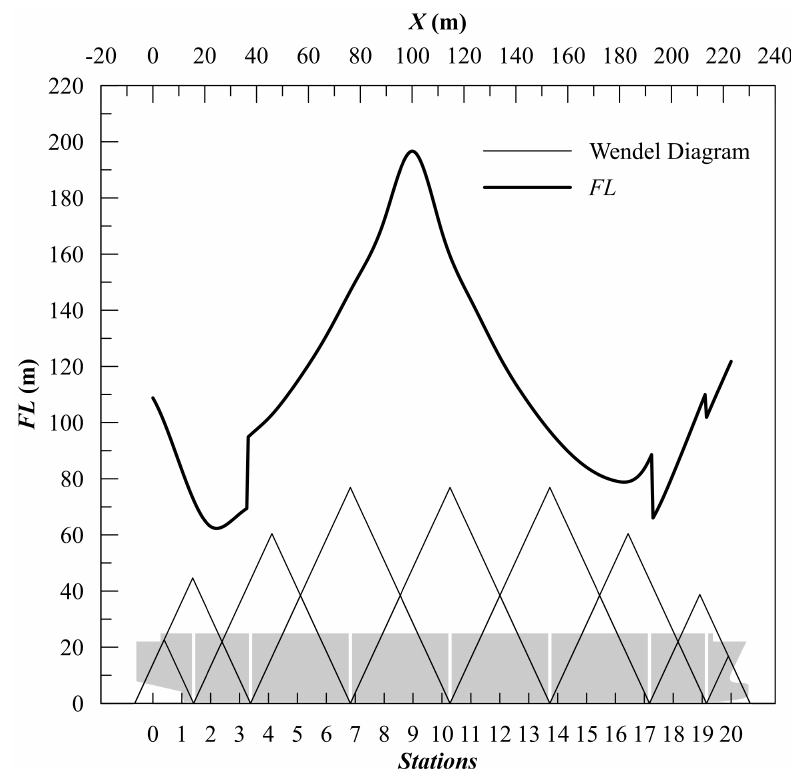
Figure 10. Equispaced subdivision: 4 cargo hold case. Table 6. Results of the equispaced bulkheads